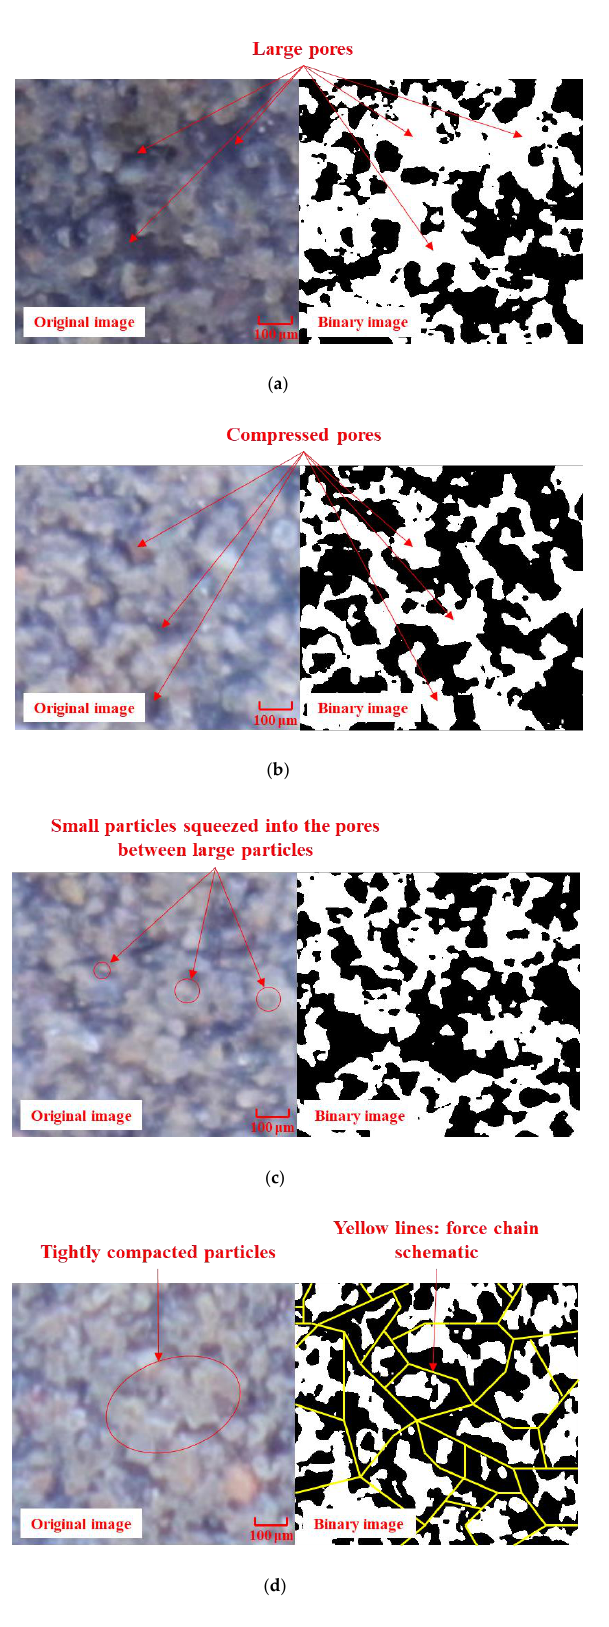
Figure 11. Schematic of mesostructure changes in tailings particles.